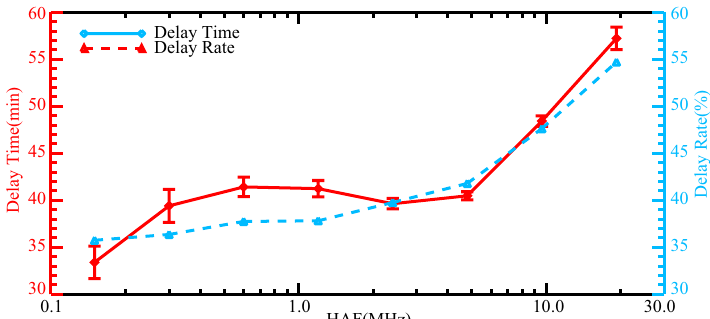
Figure 4. The flight departure delay time (red) and delay rate (blue) as a function of HAF during solar X-ray events averaged over five airports. The vertical error bars represent the standard